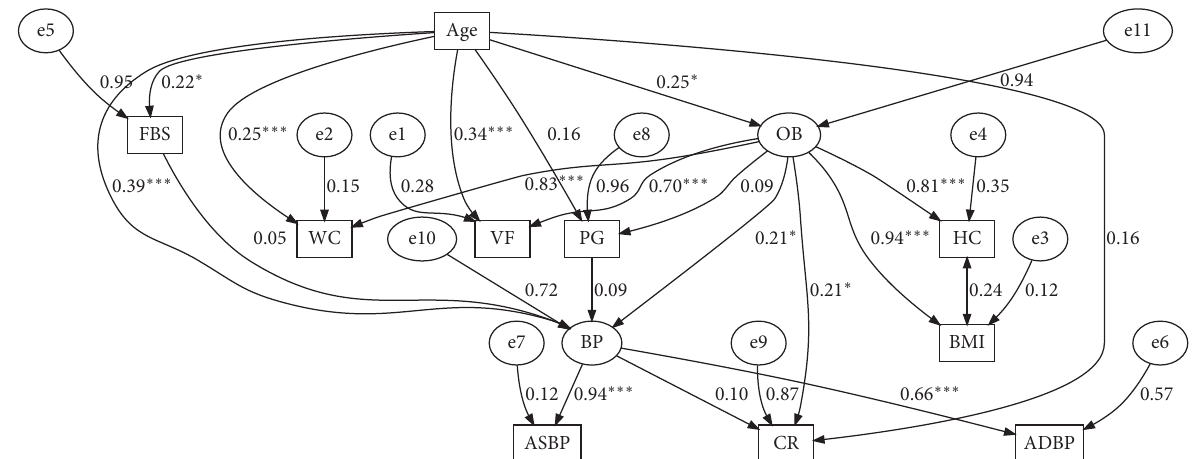
Figure 3: Structural equation model showing the effects of obesity and diabetes on blood pressure and coronary risk (Model 2).